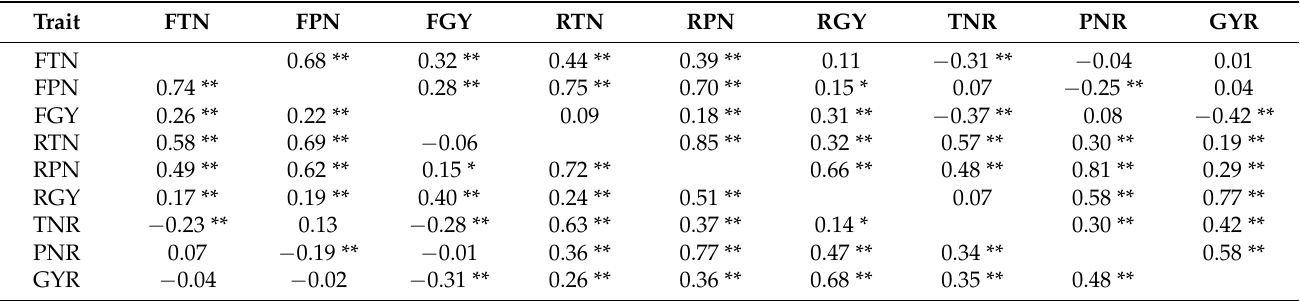
Table 2. Correlation coefficients of ratooning-ability-related traits in the IL population derived from MH63 and